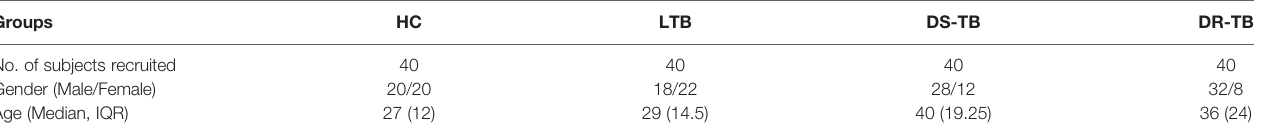
TABLE 1 | Demographics of the study population.